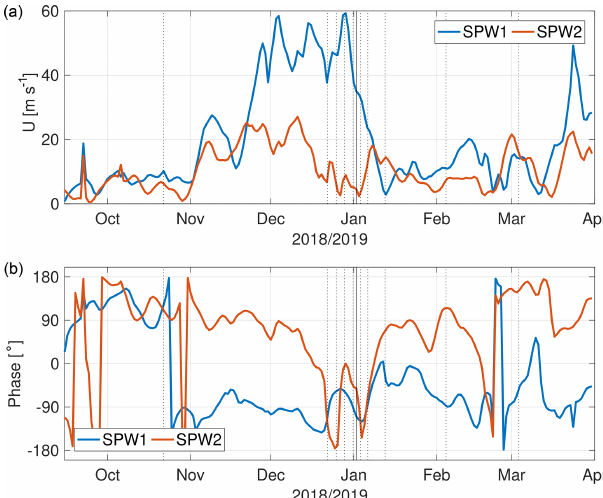
Figure 11. Amplitude (a) and phase (b) of the stationary planetary waves 1 and 2 calculated from the MERRA-2 zonal wind. The dot- ted lines indicate the dates of the polar vortex snapshots in Fig. 6 and the solid line shows the central date of the